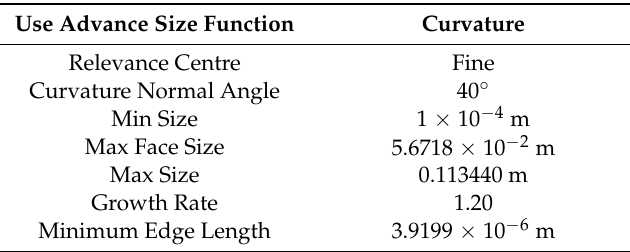
Table 2. Details of the meshing grid.